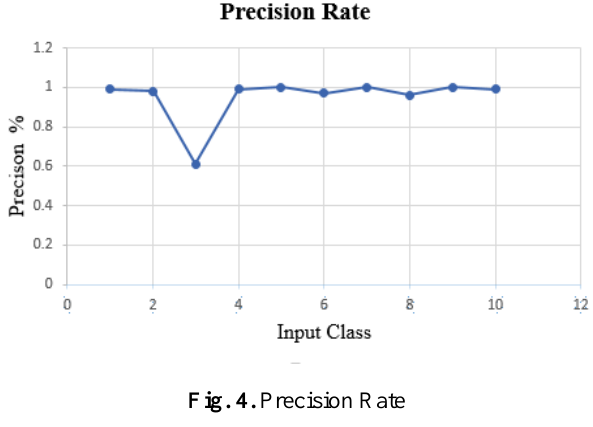
Overall Precision (OP) = (Total Precision ÷ Total number of classes) x 100, total Precision = 9.49 and total number of classes =10; therefore OP